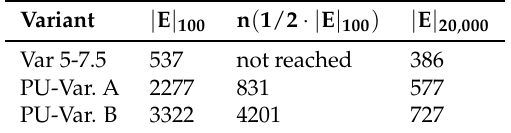
Figure 11. Results of the fatigue test; Stiffness decrease of three specimens of Var 5. Table 3. Results of fatigue testing. PU-Var. A and B taken from